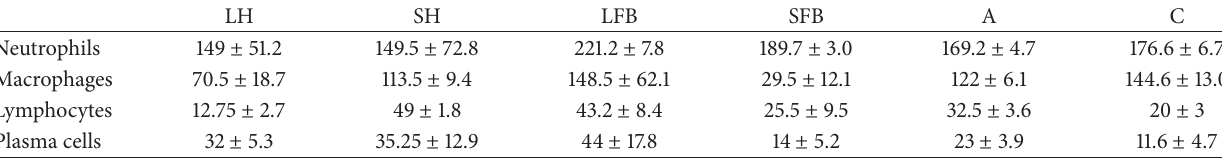
Table 1: Average cell count in diabetic rabbits’ chronic wounds. Inflammatory phase, before starting treatment, quantified in 15 random